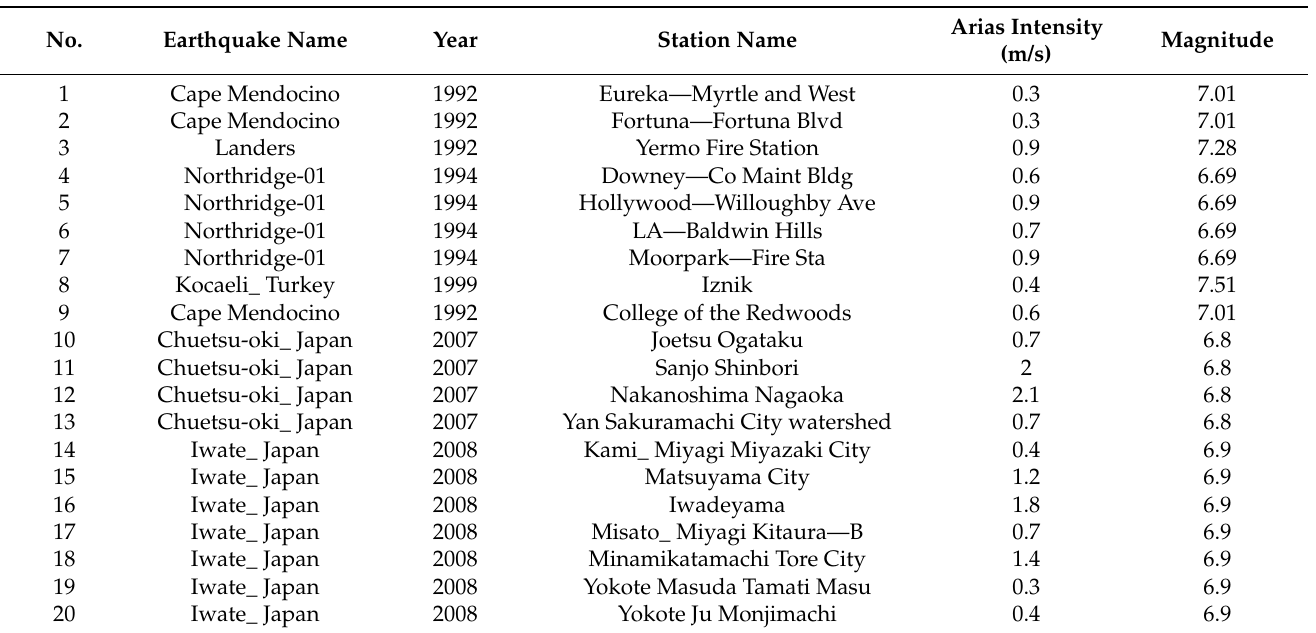
Table 1. Earthquake